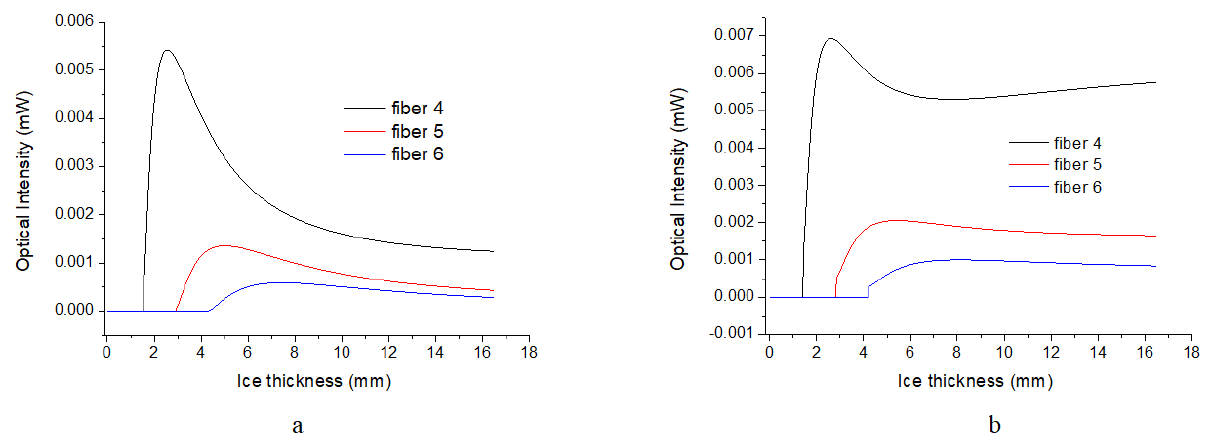
Figure 6. Simulation of the total optical intensities detected by fibers 4, 5, 6, on one side of the source fiber: ( a ) glazed ice, ( b ) for near rime ice.